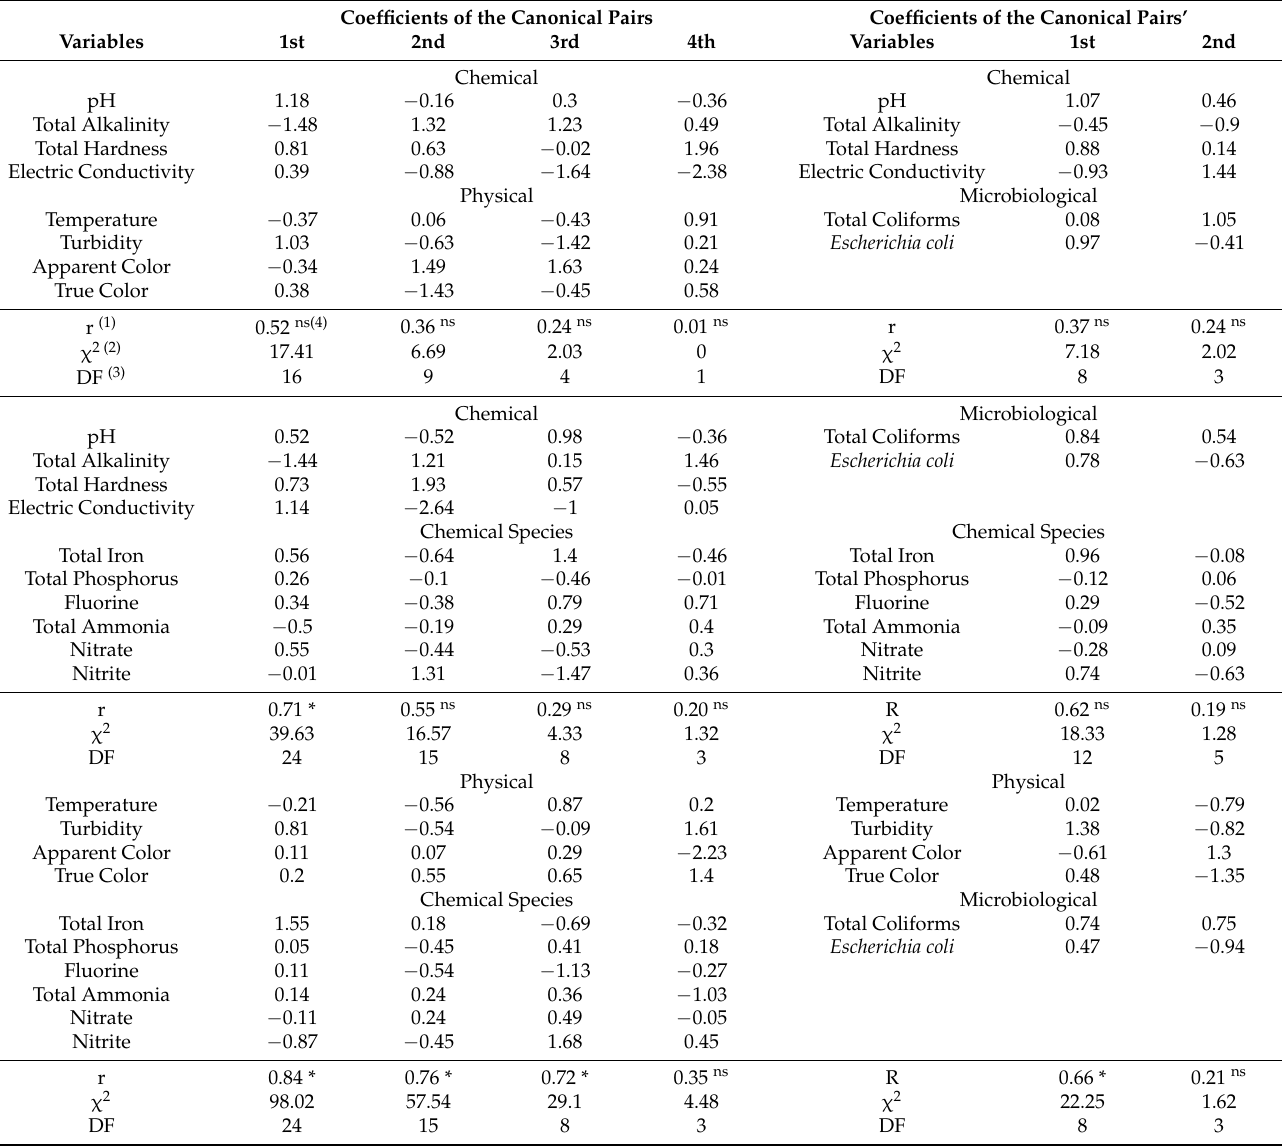
Table 1. Correlations and coefficients of estimated canonical pairs among chemical, physical, specific chemical, and microbiological variables of